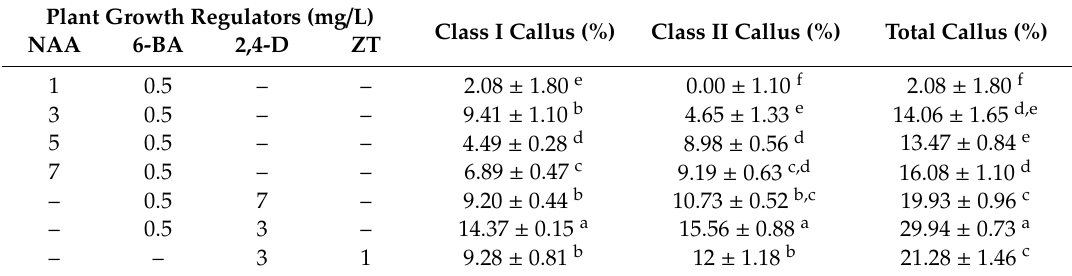
Table 1. E ff ects of plant growth regulators on class I, class II and total rate of callus induction in lotus cotyledons